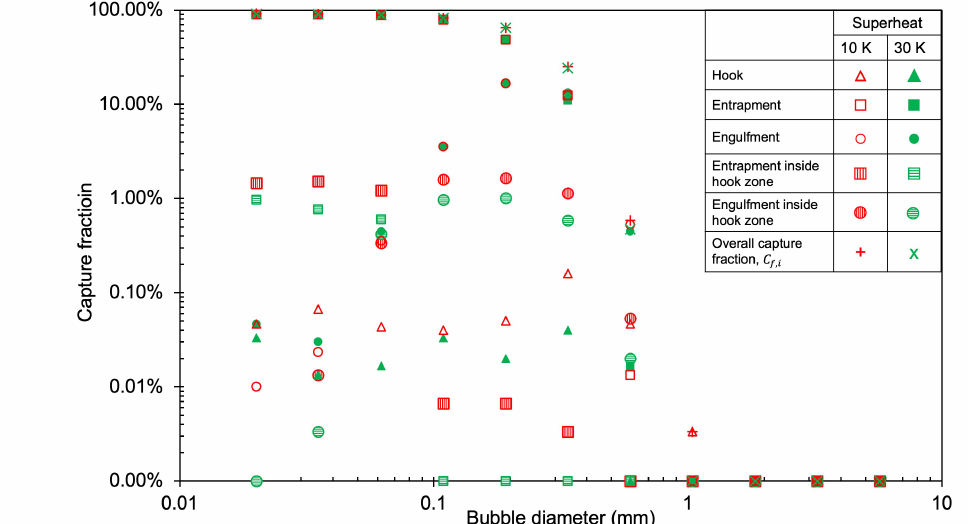
Figure 23. Overall capture fraction of different bubbles, and breakdown by hook, entrapment, and engulfment mechanisms.